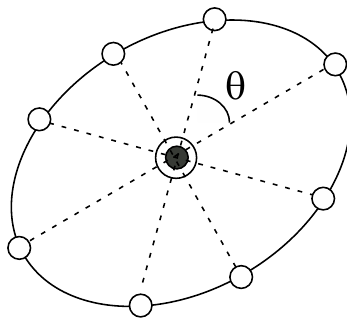
Figure 2. The ellipsoid that surrounds the parent point (the black circle enclosed by a solid circle). The equiangular points on the ellipsoid are the candidate points for the next windows.